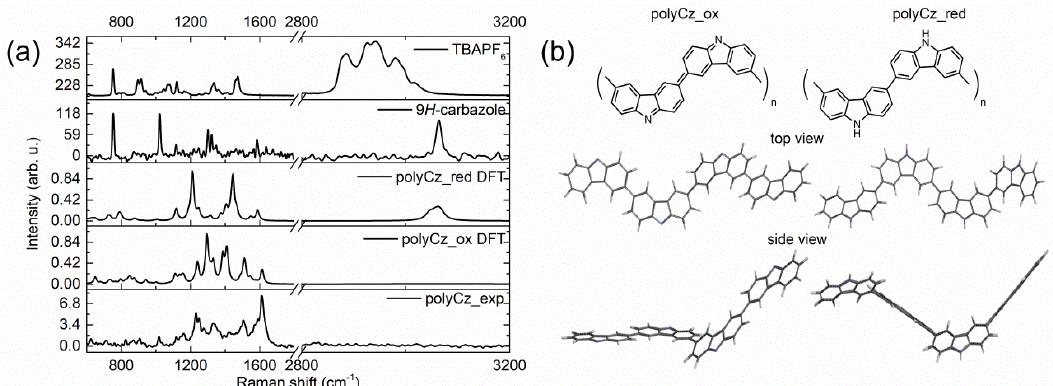
Figure 1. Raman spectra and proposed structures of polyCz: ( a ) Raman spectra of the prepared polyCz, theoretical spectra of the oxidized, reduced forms of polyCz, starting 9H-carbazole and TBAPF 6 as the supporting electrolyte, respectively; ( b ) proposed structures of the oxidized (polyCz_ox) and reduced (polyCz_red) forms.